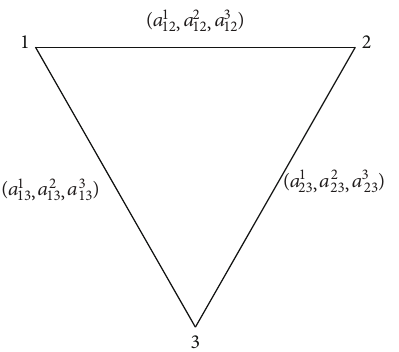
Figure 1: The topology map of complex network with